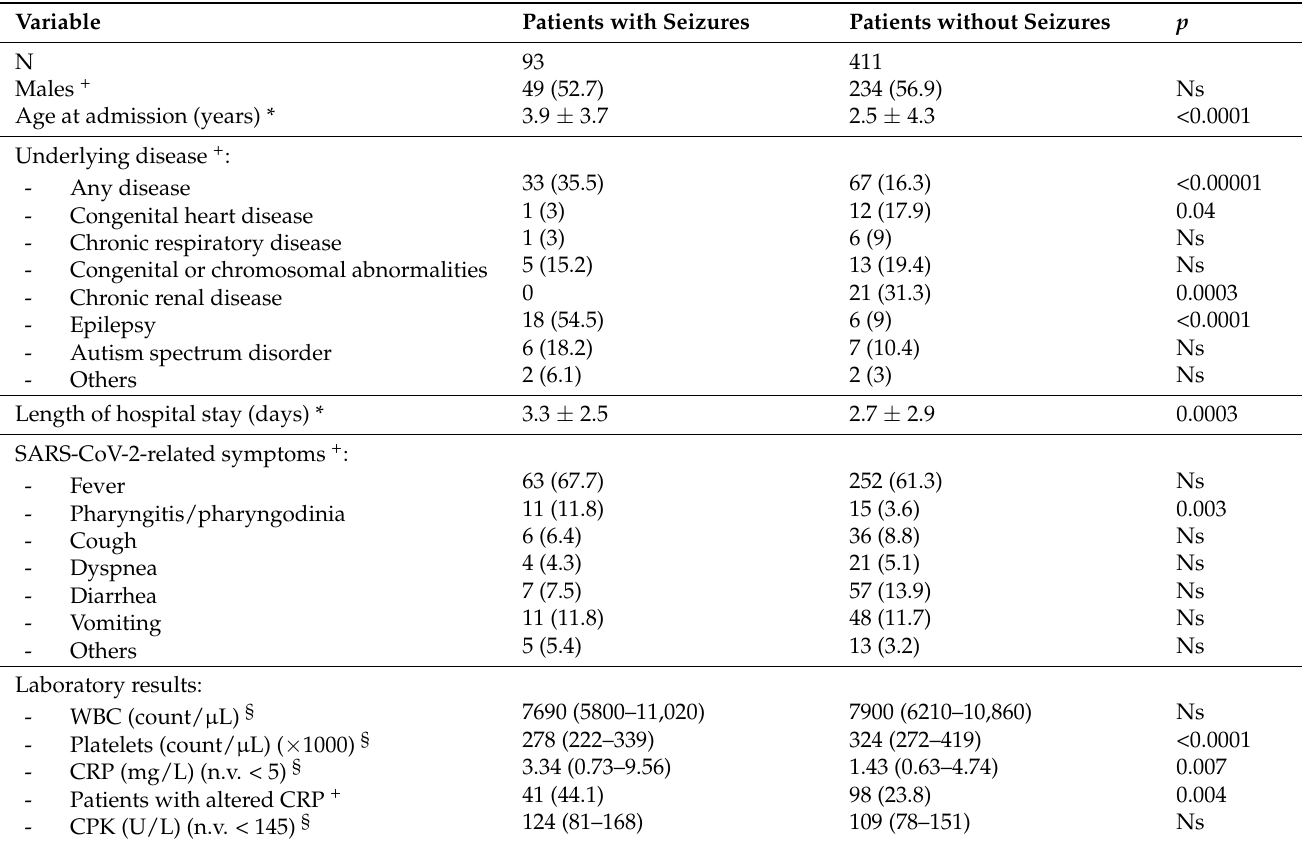
Table 1. Baseline characteristics of patients with SARS-CoV-2 infection with and without